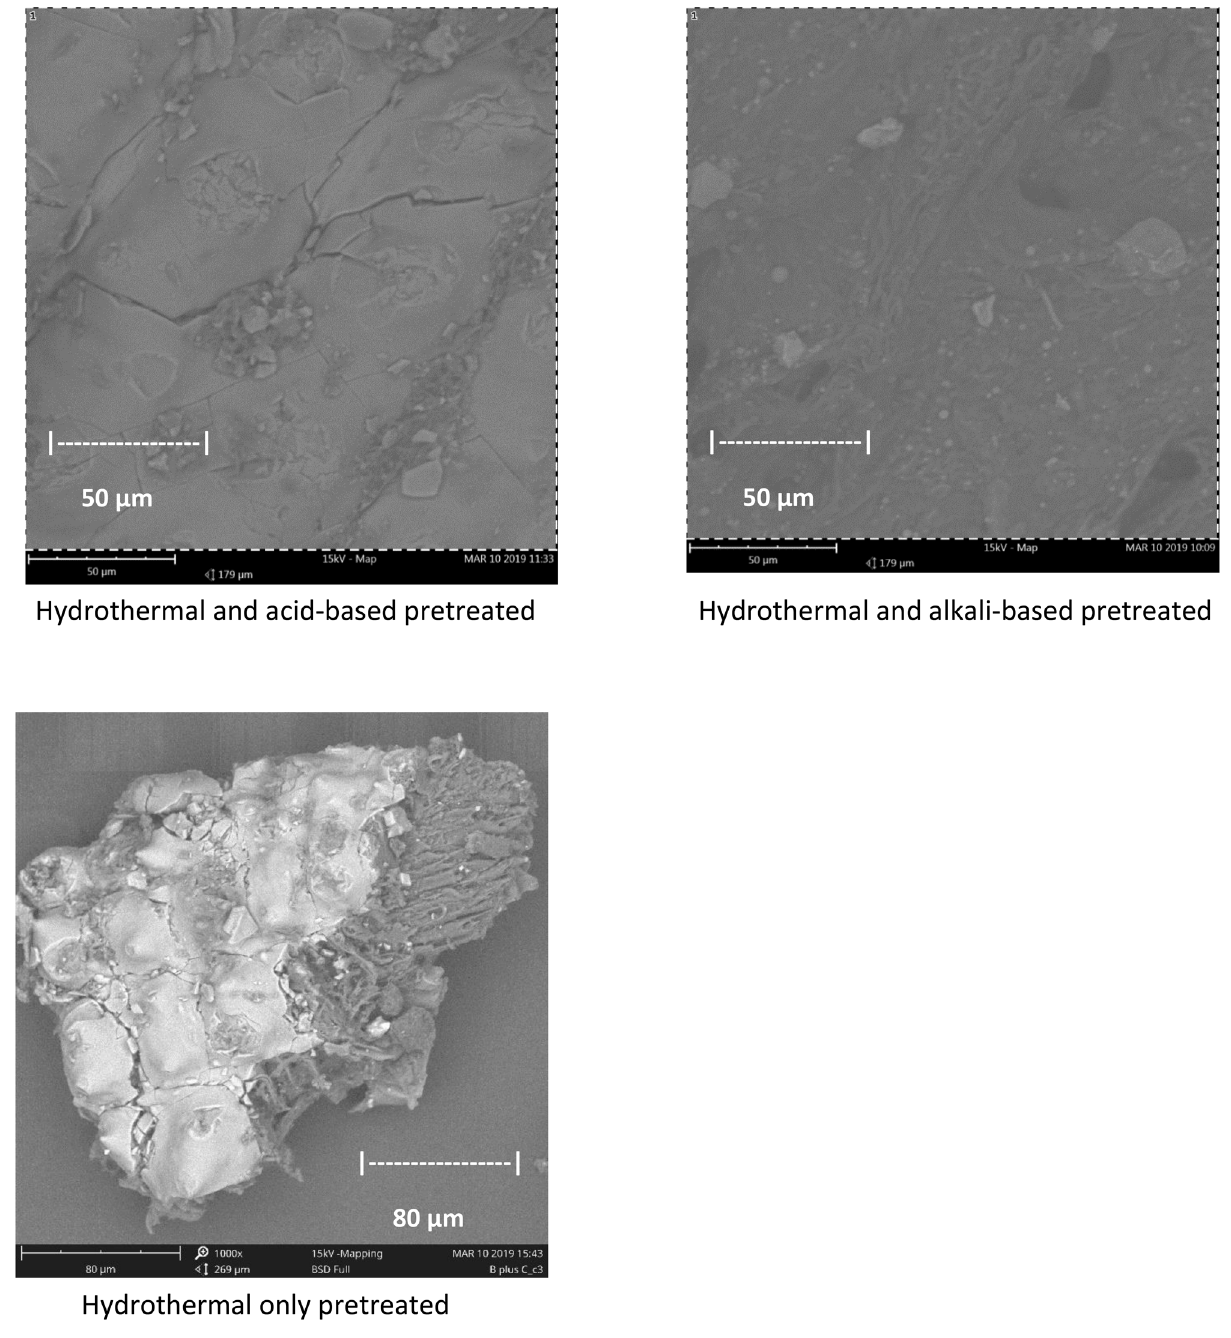
Figure 2. SEM of pretreated corn cobs plus rice husks biomass (300